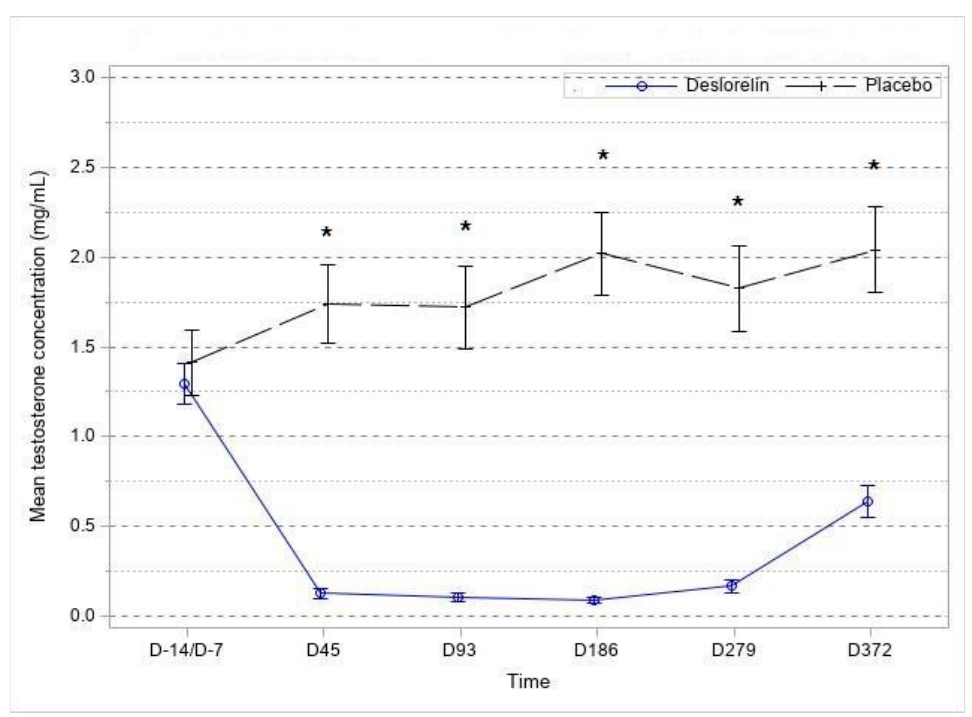
Figure 1. Evolution of serum testosterone level over time (expressed as mean ± SE). * Significant difference ( p < 0.001) between groups from D7